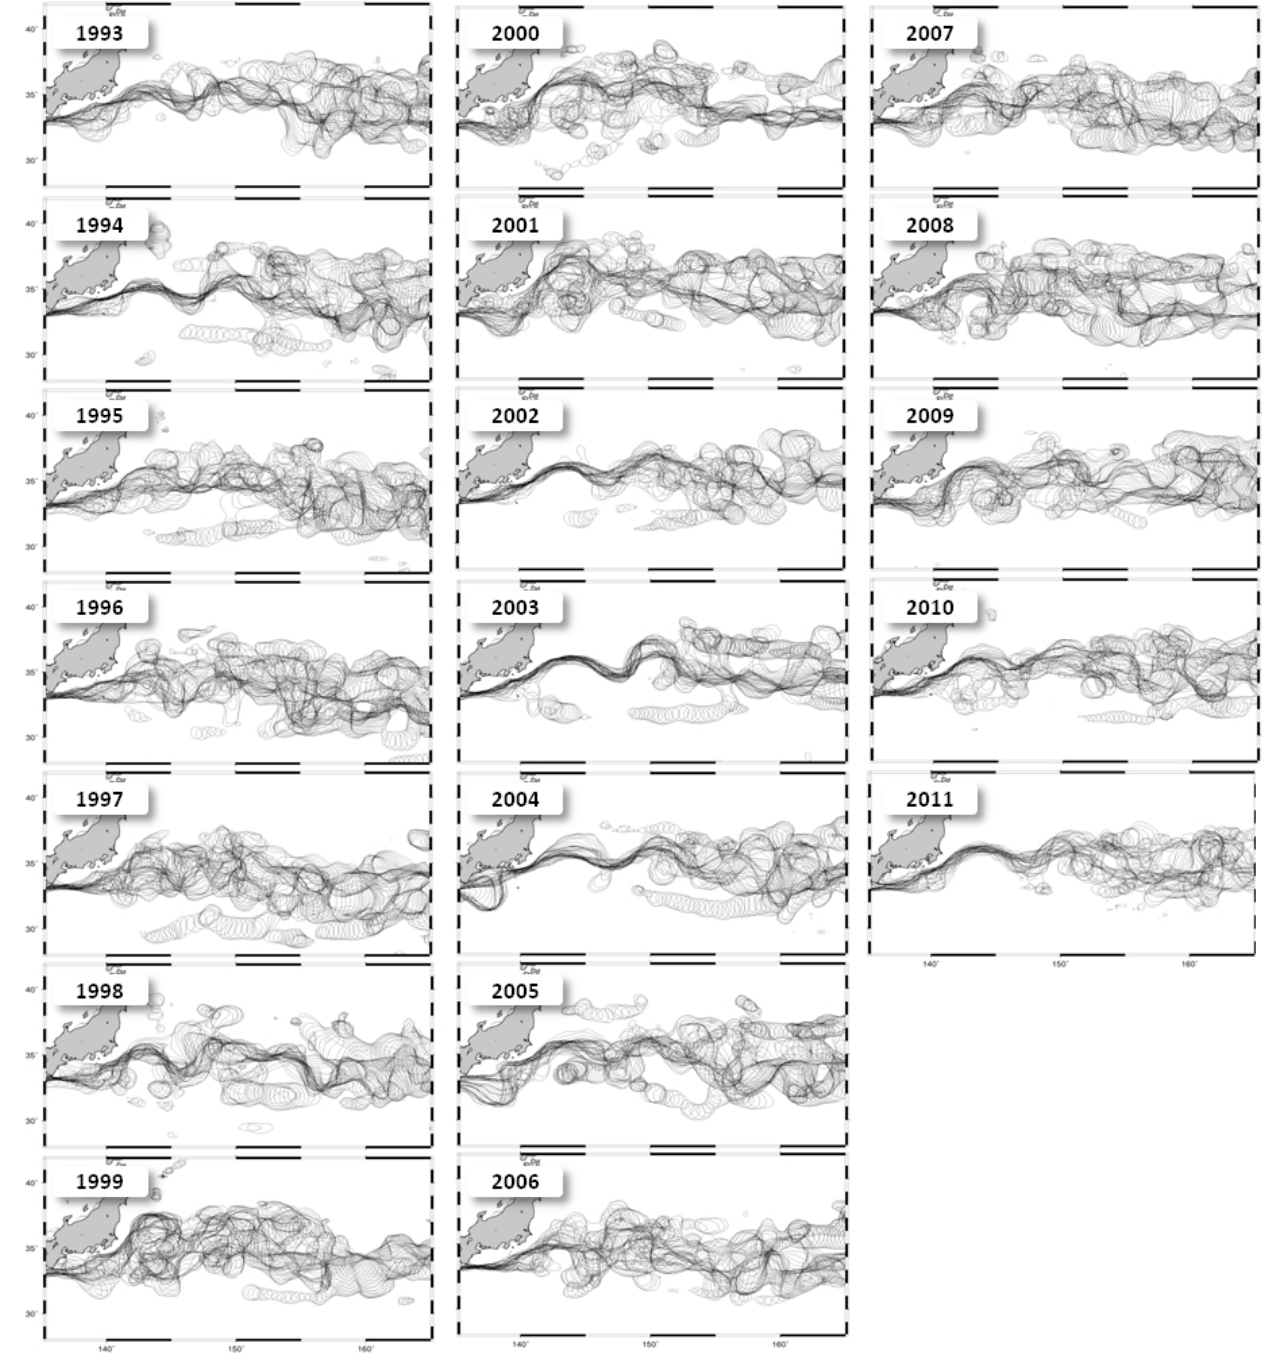
Fig. 8. Yearly path defined by the 100cm contours in the weekly ADT fields in the KE region from year 1993 (upper left panel) to year 2011 (lower right panel). Data of the Near Real Time (NRT) production mode are used during year 2011, from 26 January to 30